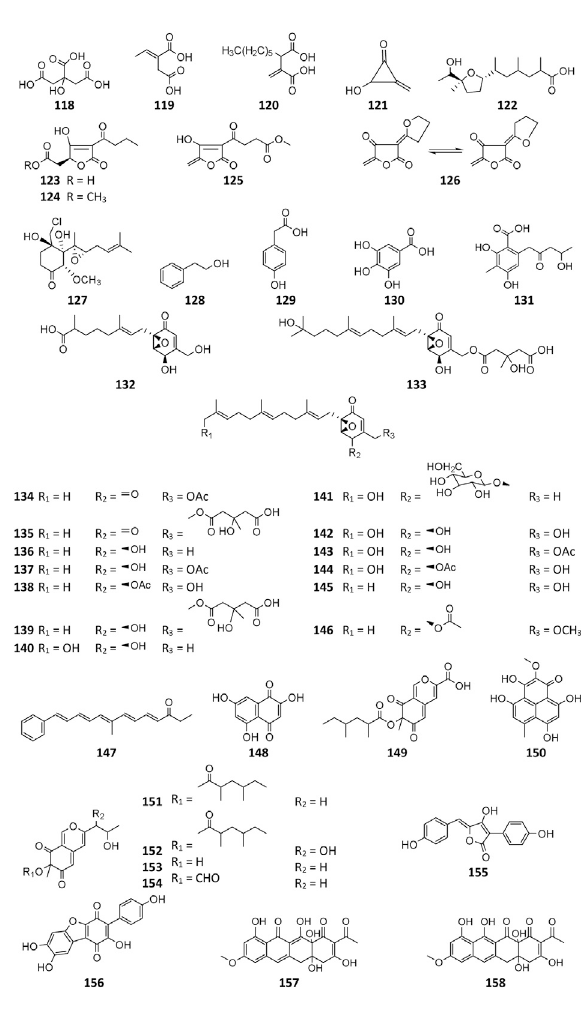
Frontiers in Chemistry |